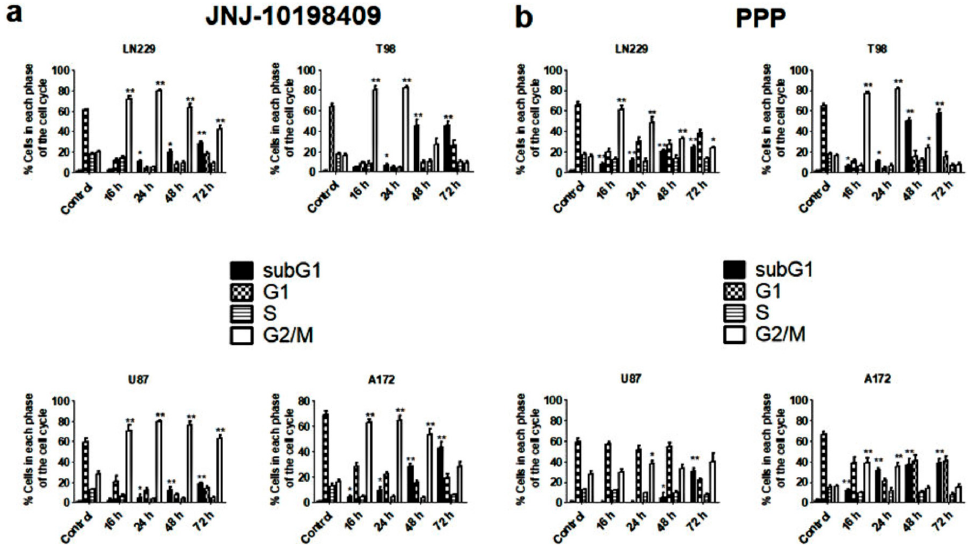
Figure 3. JNJ and PPP effects on cell cycle distribution. GBM cell lines were treated with DMSO, 500 nm JNJ ( a ) or 500 nm PPP ( b ) for 16, 24, 48 and 72 h; and cell cycle distribution of DNA content